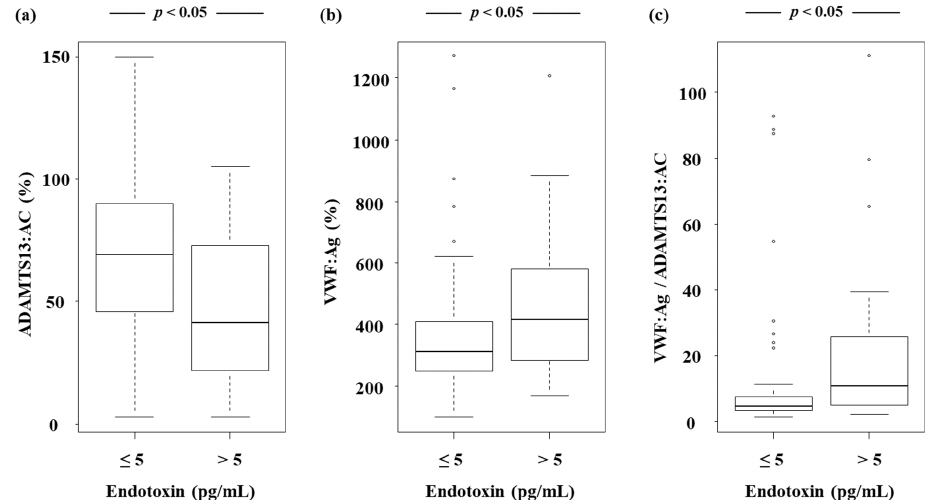
Figure 4. Relationship between endotoxin levels and ADAMTS13:AC, endotoxin levels and VWF:Ag, and endotoxin levels and VWF:Ag/ADAMTS13:AC. ( a ) Patients with endotoxin levels of >5 pg/mL had lower ADAMTS13:AC than those with endotoxin levels of ≤ 5 pg/mL ( p < 0.05). ( b ) Patients with endotoxin levels of >5 pg/mL had higher VWF:Ag than those with endotoxin levels of ≤ 5 pg/mL ( p < 0.05). ( c ) Patients with endotoxin levels of >5 pg/mL had higher VWF:Ag/ADAMTS13:AC than those with endotoxin levels of ≤ 5 pg/mL ( p < 0.05). Box plots represent, from top to bottom, sample maximum, upper-quartile range, median and lower-quartile range, and sample minimum. ADAMTS13, a disintegrin-like and metalloproteinase with thrombospondin type 1 motifs 13; ADAMTS13:AC, ADAMTS13 activity; VWF, von Willebrand factor; VWF:Ag, VWF antigen; VWF:Ag/ADAMTS13:AC, ratio of VWF:Ag to ADAMTS13:AC.